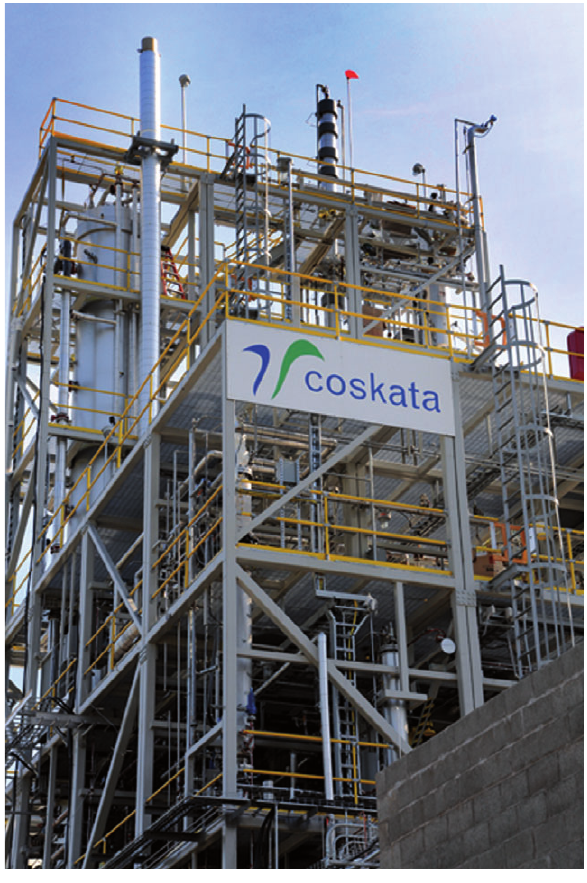
Figure 3 Coskata ’ s Lighthouse demonstration-scale facility (Madison, Pennsylvania, USA).